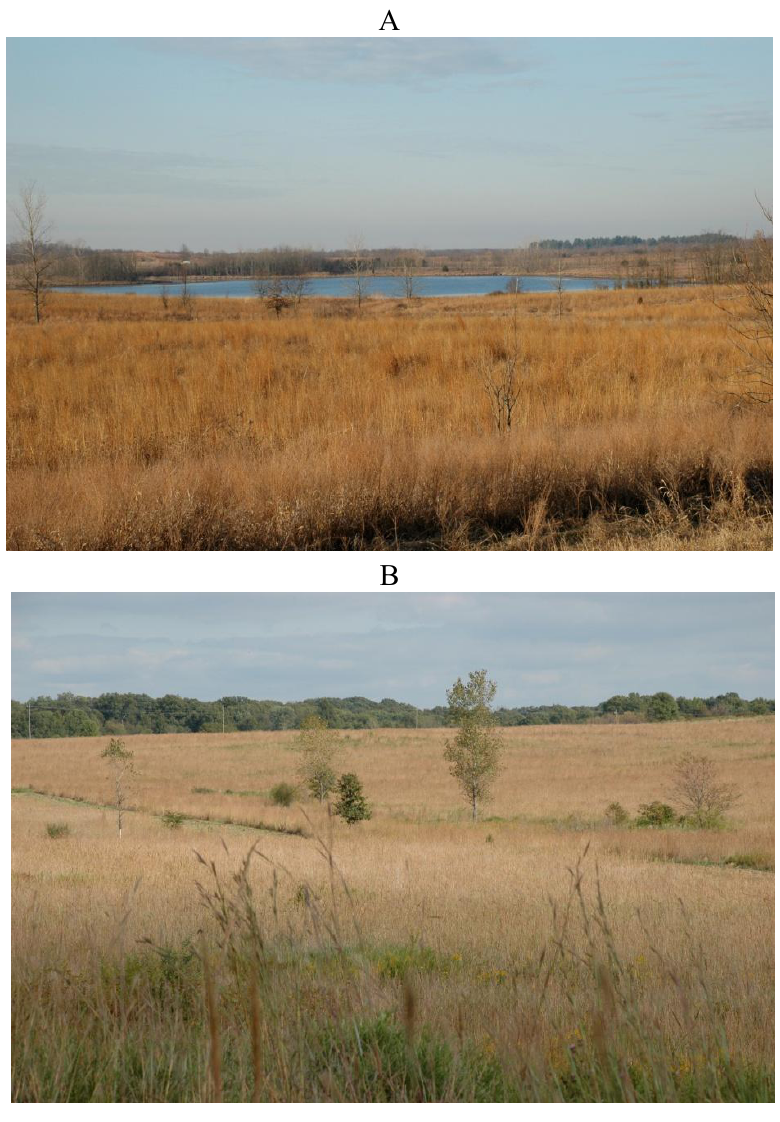
Figure 3. Hillenbrand Fish and Wildlife Area looking southwest across Moss Lake (A) and looking east from a site north of Moss Lake (B) . Photos taken by MJL on 15 March 2009 (A) and 30 September 2009